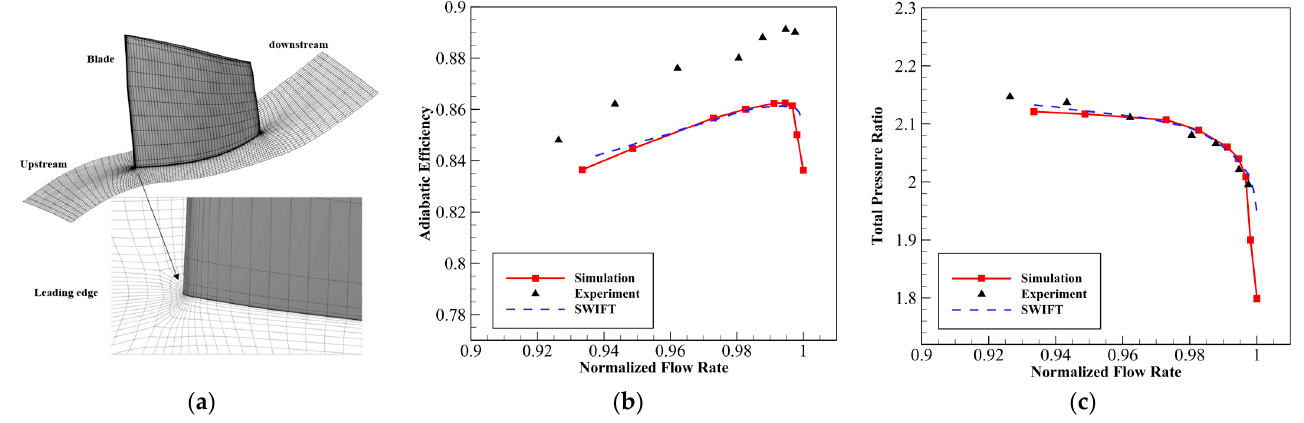
Figure 8. The mesh and its calculation results of Rotor 37. ( a ) The illustration of the Rotor 37 calculation meshes. ( b ) The adiabatic efficiency performance of simulation, experiment, and SWIFT [41]. ( c ) The total pressure ratio performance of simulation, experiment, and SWIFT.